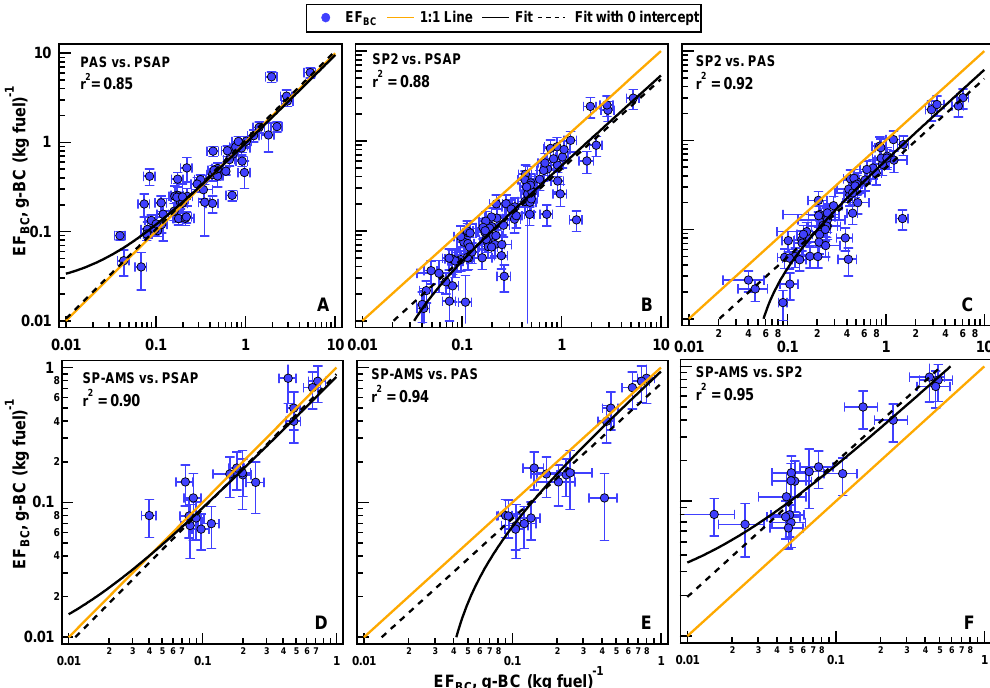
Fig. 2. Comparison of EF BC values determined usingBC measurements from four different instruments: the PAS, PSAP, SP2 and SP-AMS. The yellow line is the 1 : 1 line, the dashed black line is the best fit constrained to go through the origin and the solid black line is an unconstrained fit. All fits were performed using orthogonal distance regression, with the first instrument listed in each panel being presented on the y axis. Note the different scales for the figures in the top row compared with the bottom